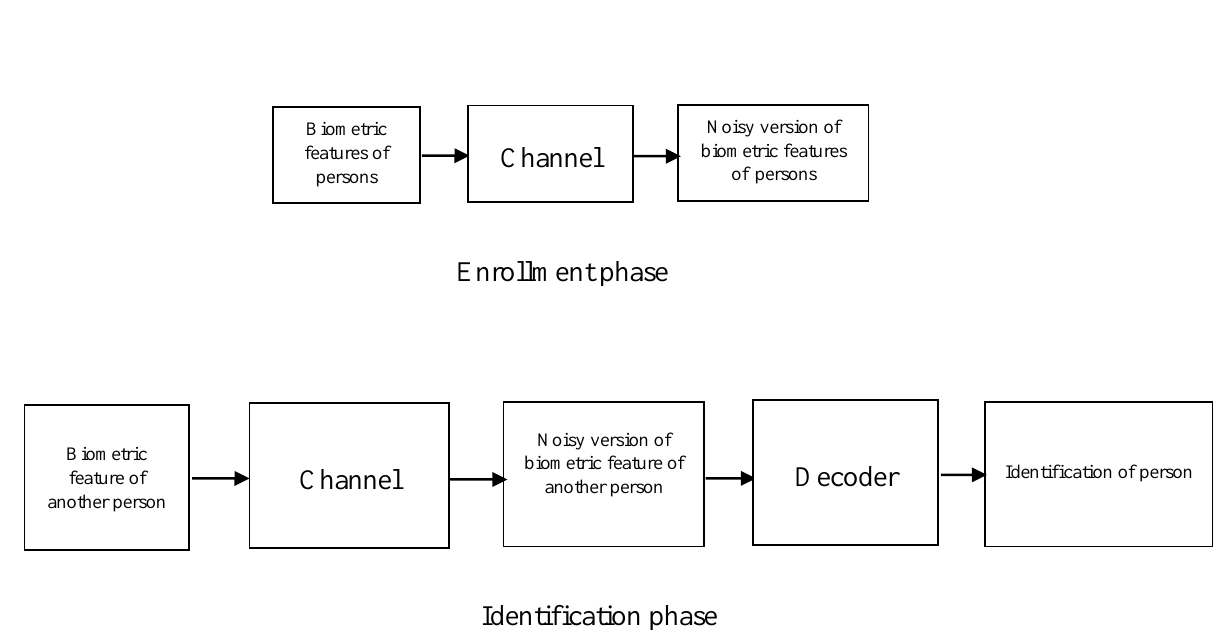
Identification Fig3. The model of biometric identification system